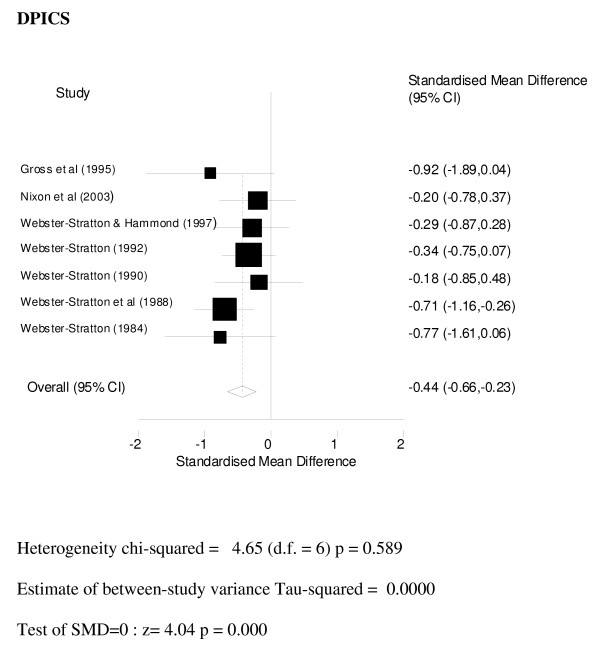
Meta-analysis DPICS.